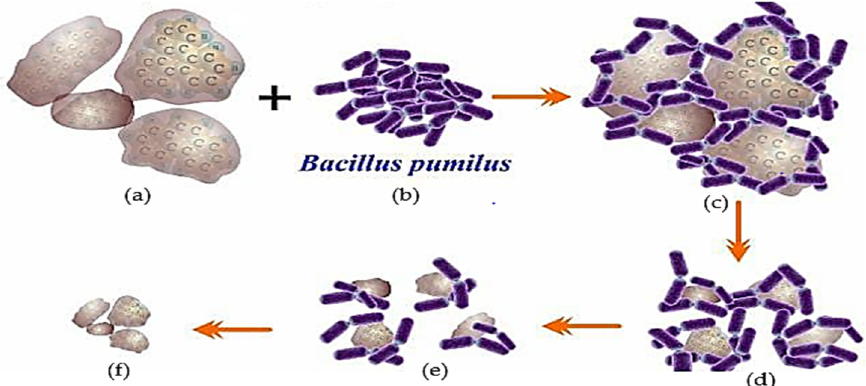
Figure 4. Description of the biodegradation process of PAH (pyrene) contaminants using one type of bacteria, Bacillus pumilus type. ( a ) Pyrene as a substrate; ( b ) Bacillus pumilus (Bp); ( c ) pyrene-Bp complex; ( d ) Degraded pyrene; ( e ) The population of Bp was significantly reduced and the pyrene concentration was not significantly reduced and ( f ) the remaining pyrene was not degraded, an illustration [16,71,99,116].